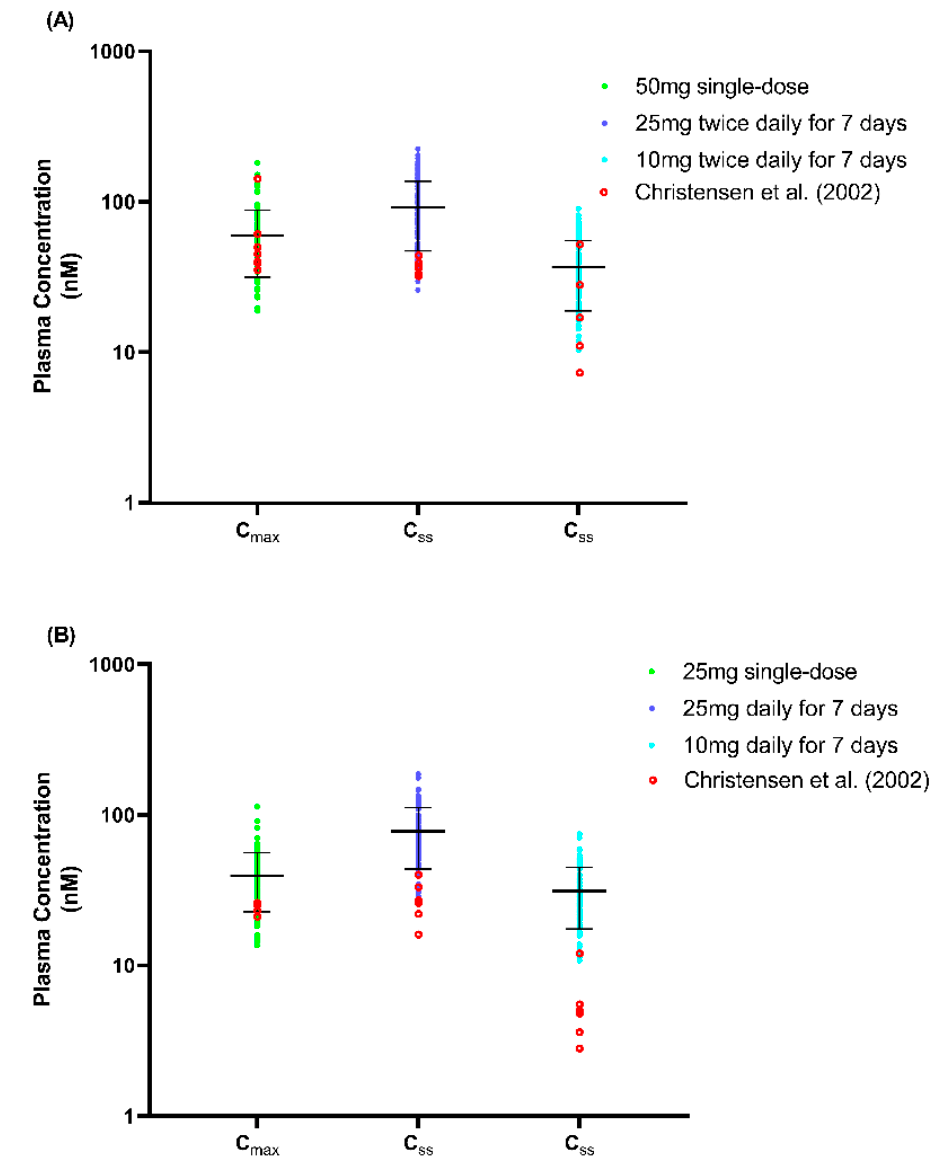
Figure 7. Predicted maximum concentration and steady-state concentration for single-dose and multiple-dose studies. ( A ) EM CYP2D6 phenotype population; ( B ) PM CYP2D6 phenotype popula- tion; solid circles arranged vertically represent the predicted values for each dose. Horizontal lines on the coloured data points represent the mean and SD. Red, open circles represent the observed individual data from Christensen et al. [51]. C max , maximum concentration for single-dose; C ss , average trough concentration at steady-state for Day 6 and Day 7.